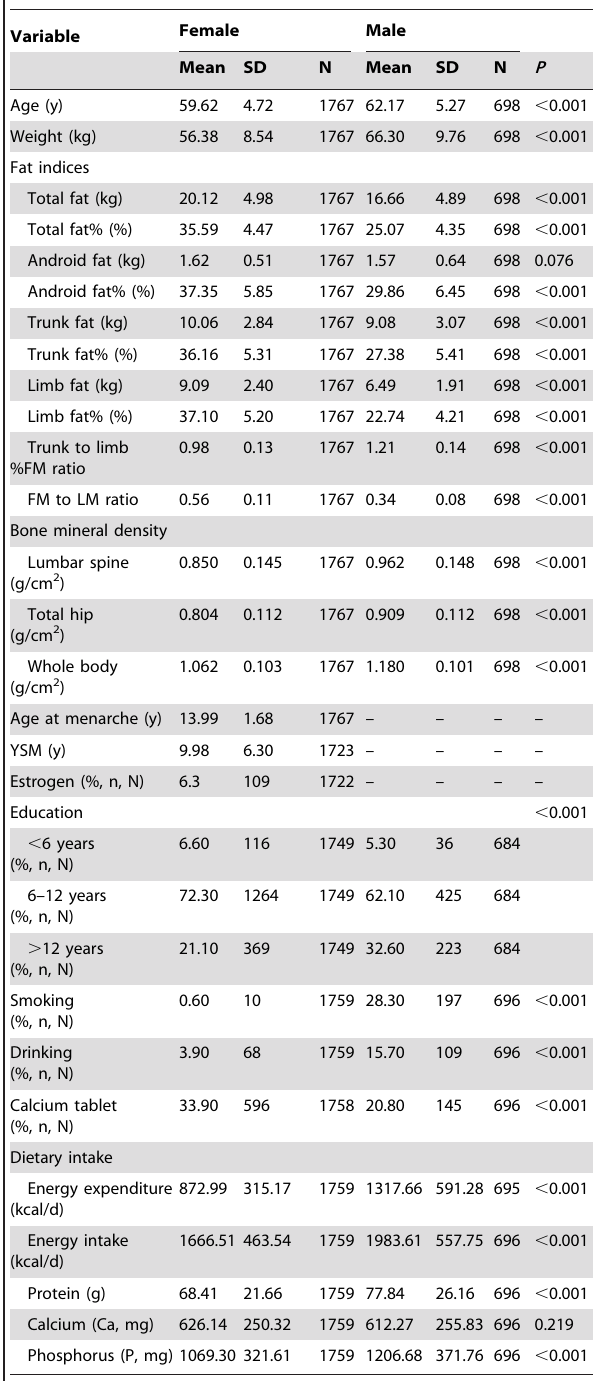
Table 1. Characteristics of the study